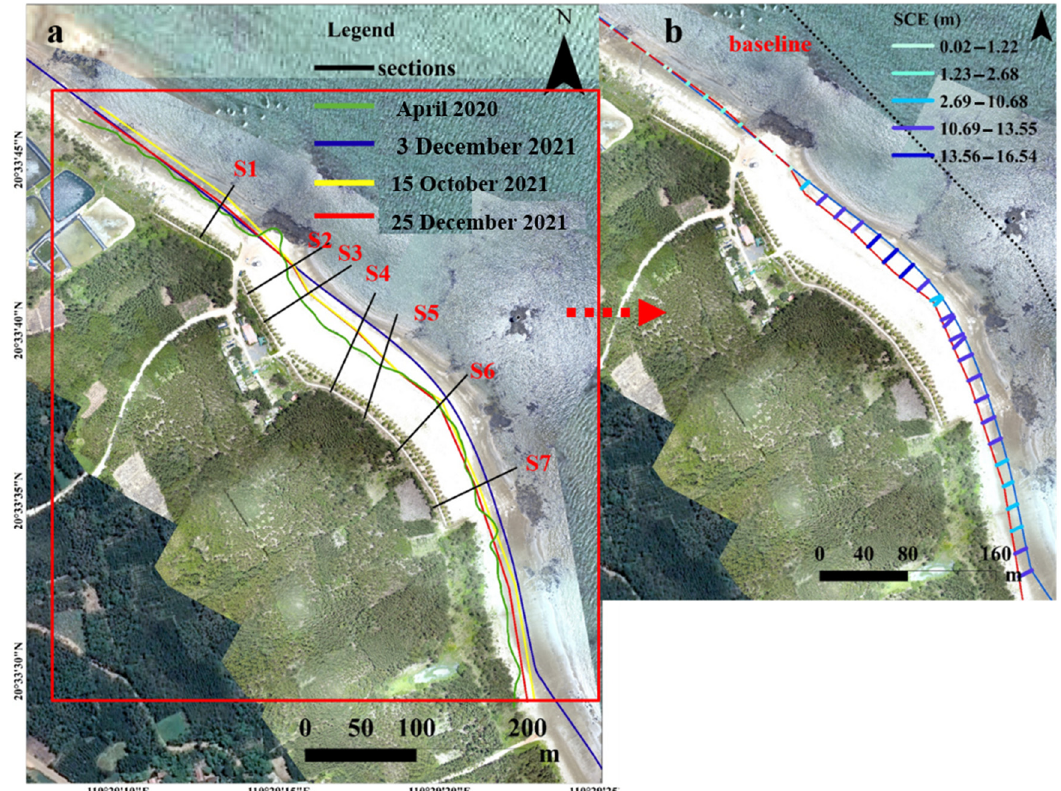
Figure 10. ( a ) Schematic of coastline evolution at a short-term scale. The coastlines of different dates are shown in this figure, while the solid black lines depict the location of sections 1–7; ( b ) verification of coastline accuracy, the dates of selected coastlines are 3 December 2021 (the blue one) and 25 December 2021 (the red one), respectively.